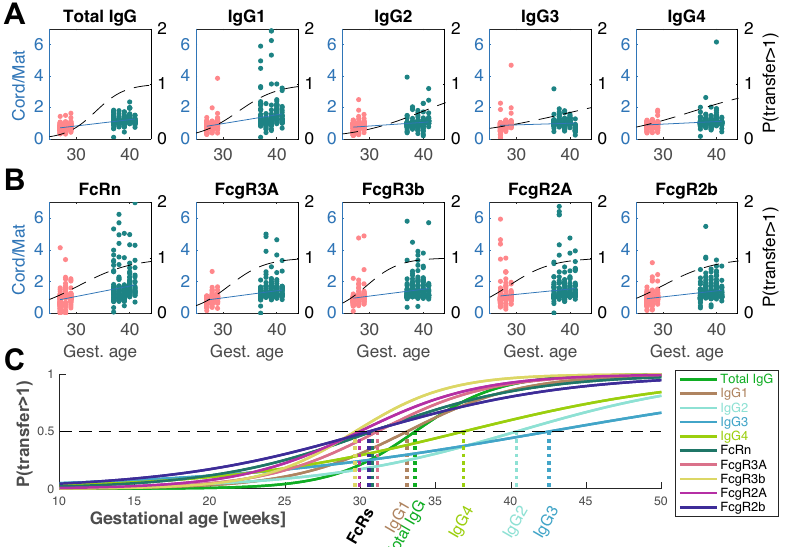
Figure 5. Preferential and early transfer of functional antibodies. ( A , B ) Transfer ratios (cord/maternal) per person-antigen are shown in pink and green for PT and FT newborns, respectively. Each dot represents the transfer ratio of an antigen-specific measurement for a maternal:cord pair plotted based on gestational age. The ratios where maternal levels were below PBS levels as well as measurements with transfer ratios > 7 were excluded from the analysis for more stable results. Linear regression lines are overlaid in blue. The regression coefficients for total IgG, IgG1, IgG2, IgG3, IgG4, FcRn, FcR3A, FcR3B, FcR2A and FcR2B were calculated to equal 0.04, 0.07, 0.06, 0.02, 0.06, 0.09, 0.05, 0.05, 0.04, and 0.03, respectively. Additionally, logistic regression was performed and the probability of transfer > 1 was calculated and plotted in dashed black curves (right y axis). ( C ) The individual probabilities for each Fc-readout was plotted separately and overlaid for comparison. The likelihood of transfer ratio ≥ 1 surpasses the likelihood of transfer ratio < 1 was marked on the graph with hatched lines for each